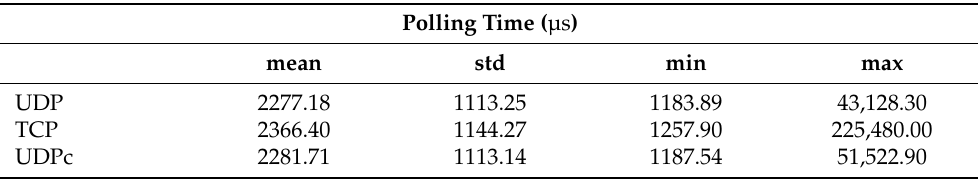
Table 4. Polling time statistics for different transport layers on